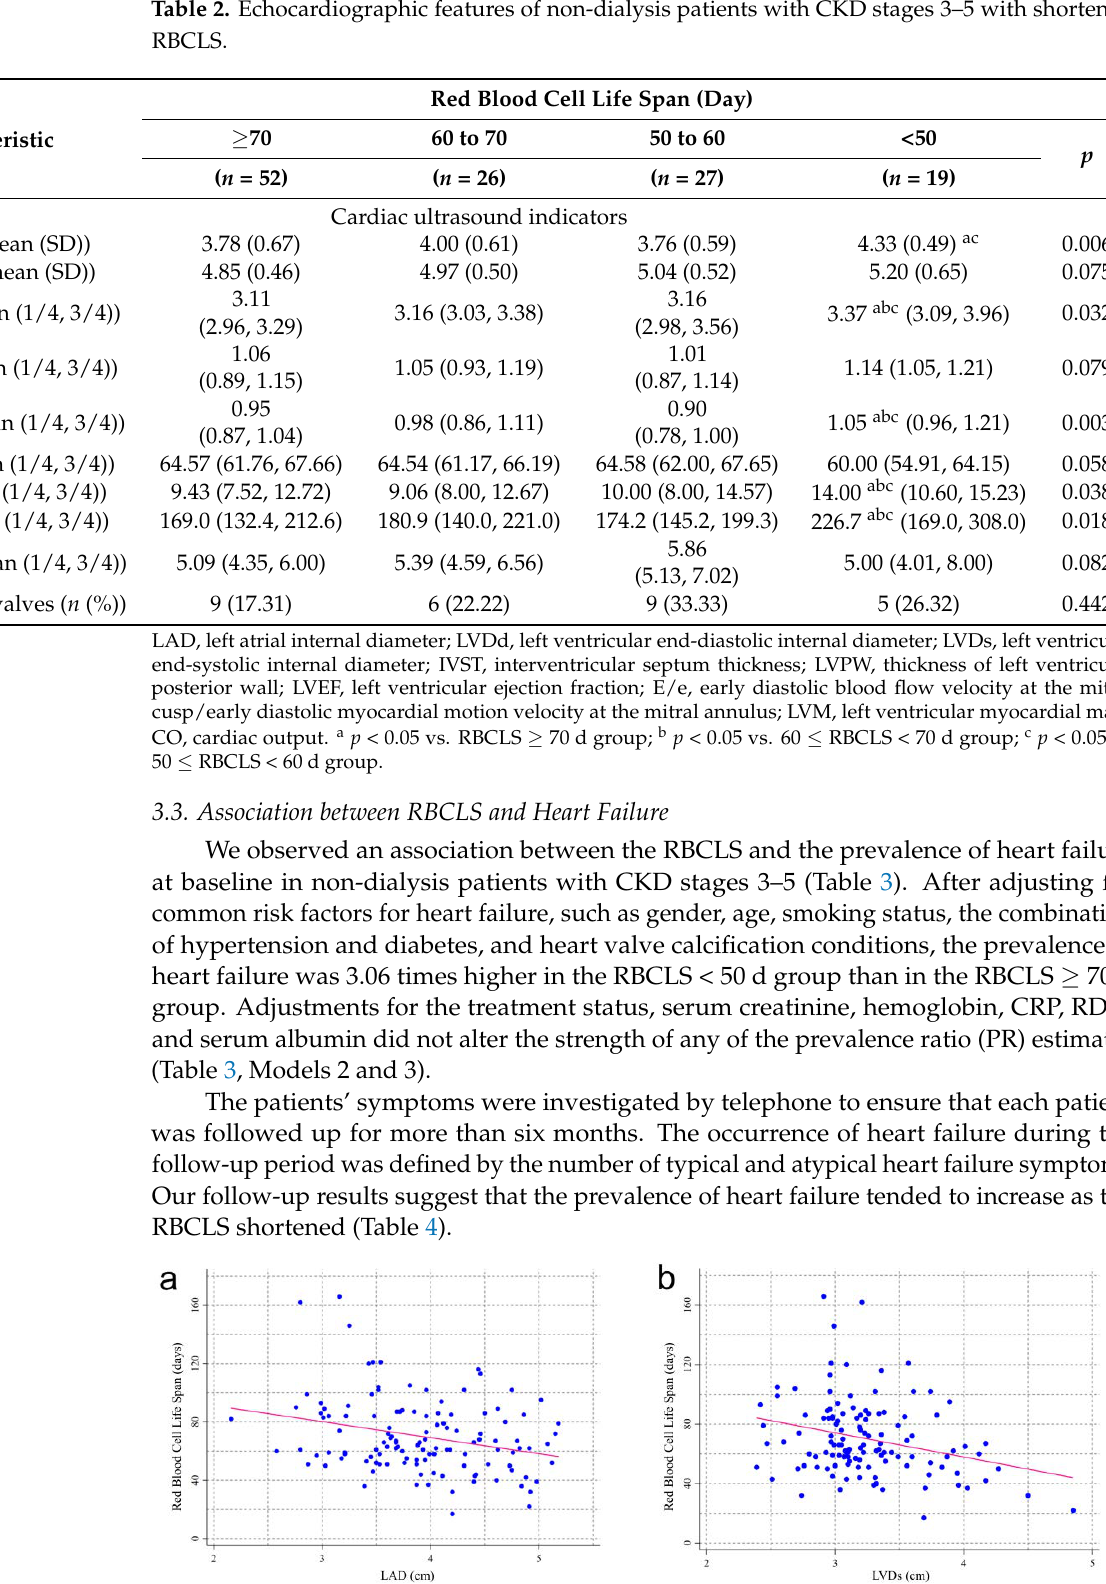
Table 2. Echocardiographic features of non-dialysis patients with CKD stages 3–5 with shortened RBCLS.